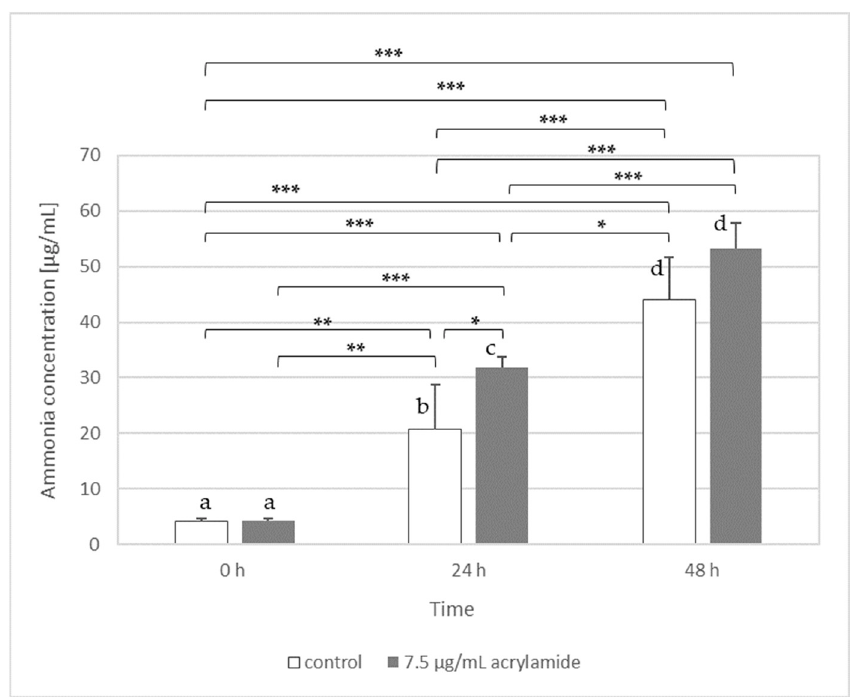
Figure 2. The production of ammonia by L. acidophilus LA-5 assessed in MRD medium without (control) or with 7.5 µg/mL of acrylamide after 24 h and 48 h of incubation with bacteria at 37 °C and pH 6. The same letters above bars indicate the lack of statistical differences. Significance level: * p < 0.05, ** p < 0.01, and *** p < 0.001.